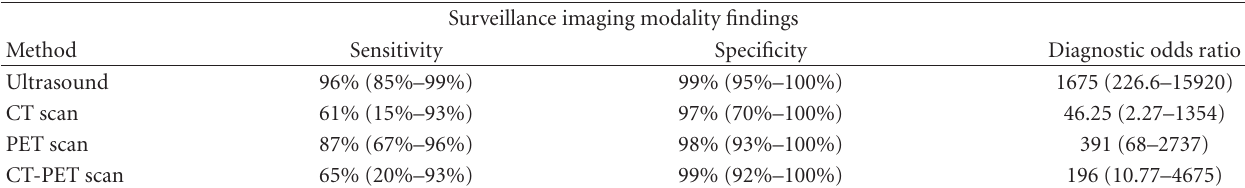
Table 1: Surveillance of melanoma patients (adapted from Xing et al.